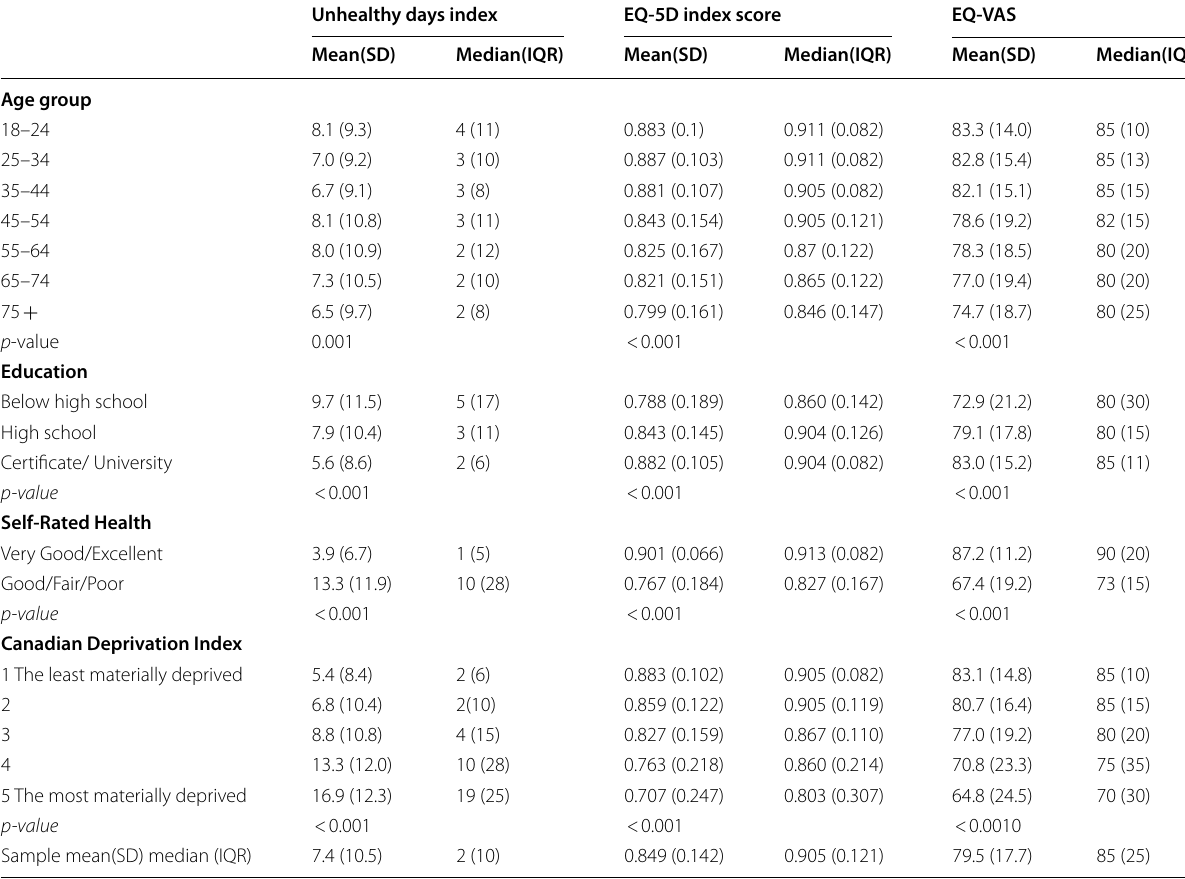
Table 2 The CDC Healthy Days and EQ-5D-5L measures by sociodemographic